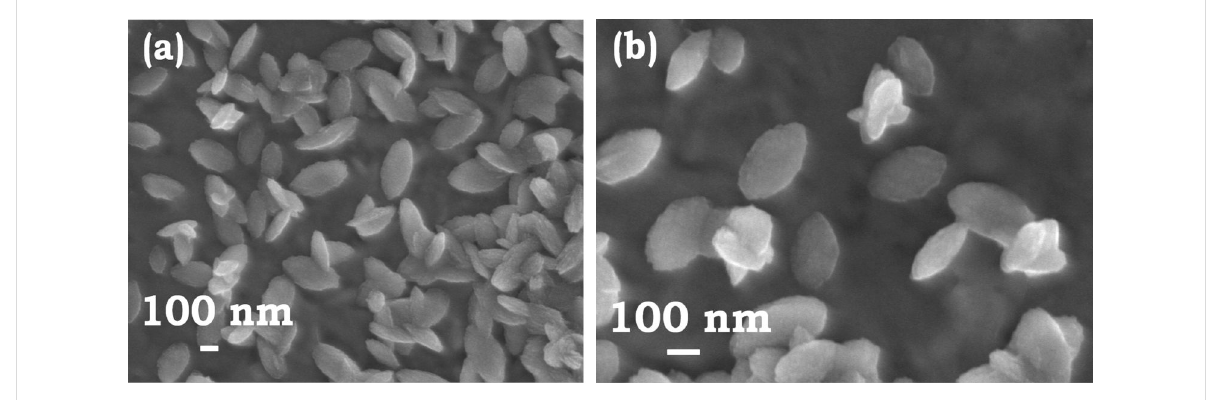
Figure 4: Cobalt nanoplates formed under ultrasonication. Micrographs captured after 45 min emphasize the importance of ultrasonic treatment to reduce the aggregation and interlocking tendency in nanoplates. Typical sizes: diameter d = 260 nm; thickness t = 34 nm.